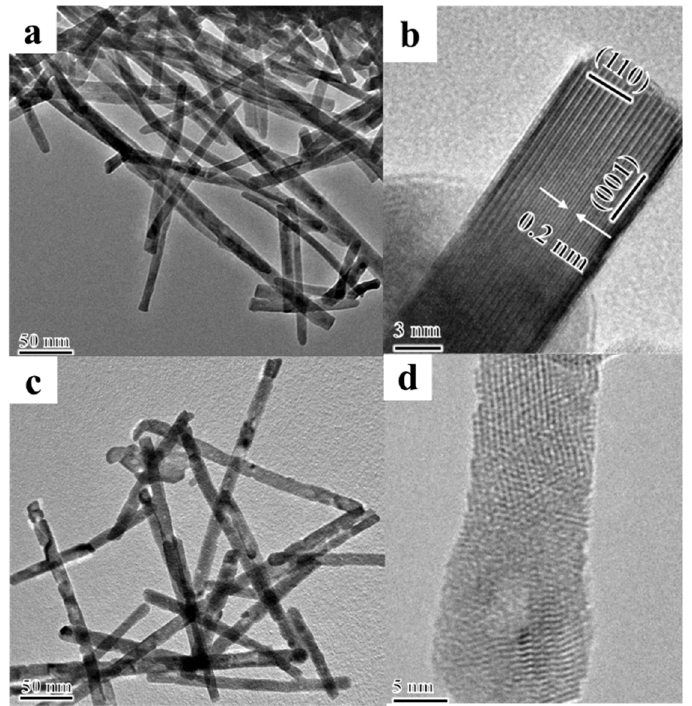
Figure 4. TEM and HRTEM images of pure La 2 O 3 ( a , b ) and Mg-La 2 O 3 ( c , d ) catalysts.